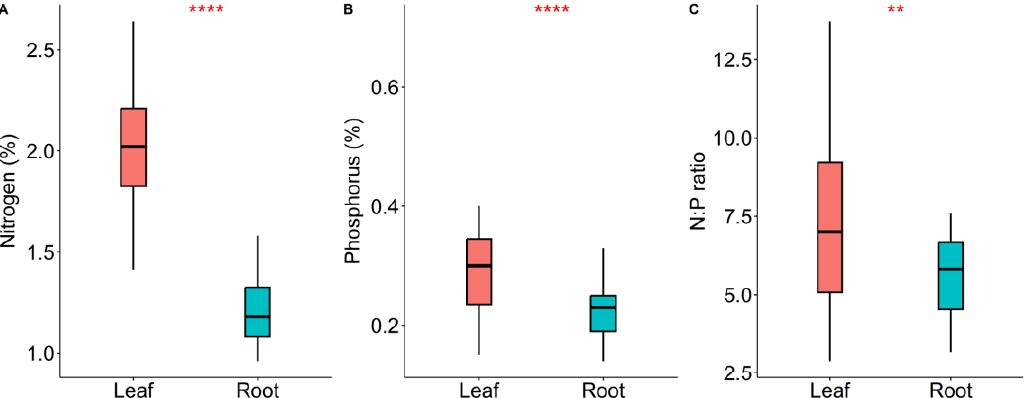
Figure 1. A comparison of the differences in the N mass ( A ), P mass ( B ), and N/P ( C ) of different organs (leaf and root). * represents p < 0.05, ** represents p < 0.01, **** represents p < 0.0001. Table 1. Variations in the N mass , P mass and N/P ratio of leaves, roots and soil.